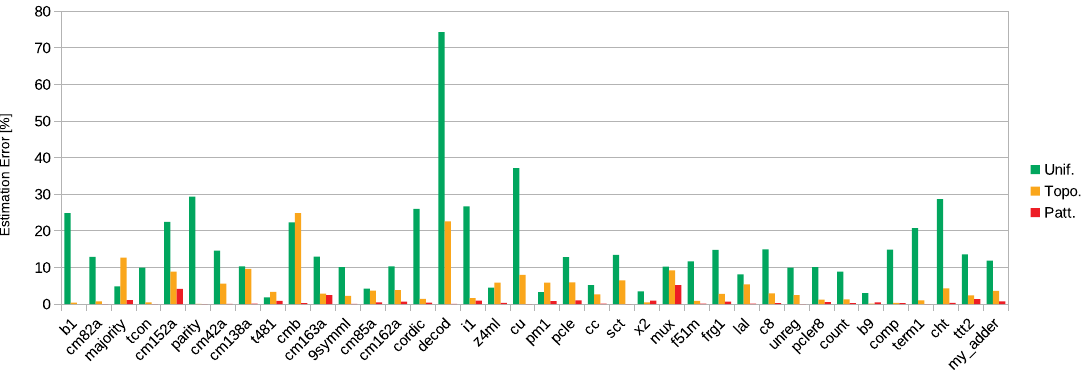
Figure 6. Errors of the SEV estimation processes. For each benchmark circuit, it presents the absolute value of the error of the three SEV estimations at the CLB level in comparison to the reference estimation at the transistor